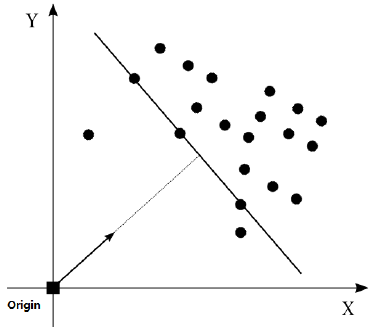
Figure 8. Principle diagram of